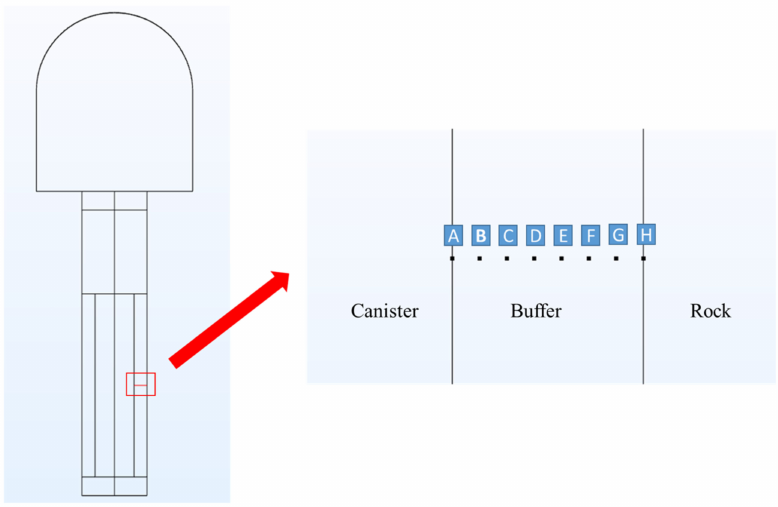
Figure 11. Points for temperature calculation within the buffer, each gap of points is 5 cm.